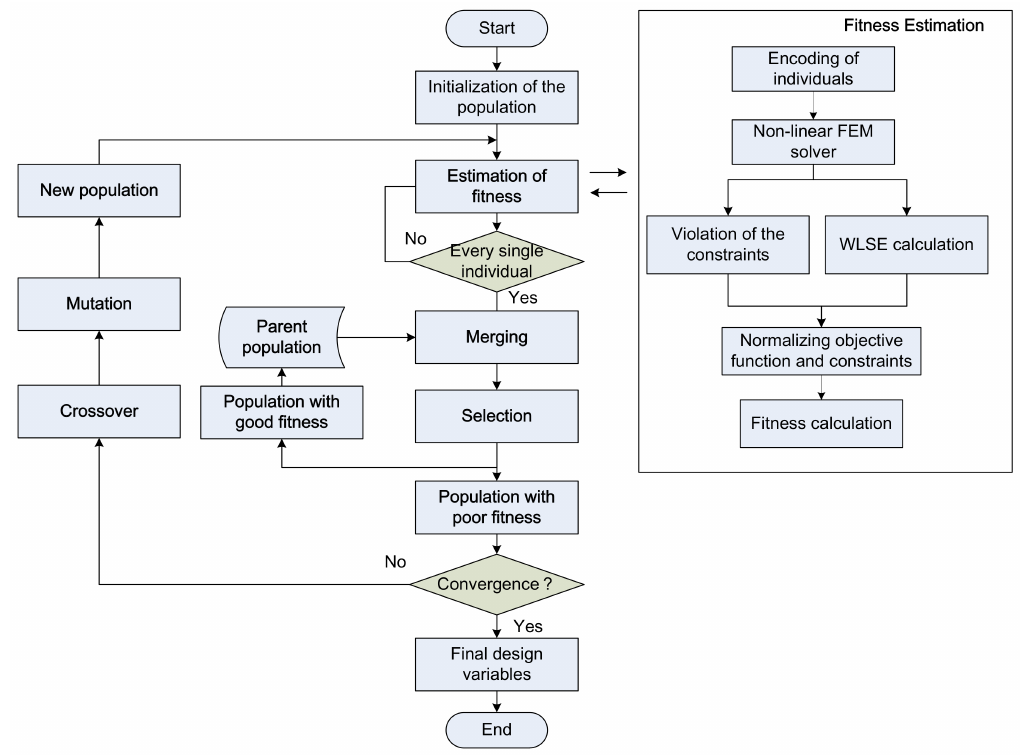
Figure 8. Optimization framework of the compliant skin based on NSGA-II.